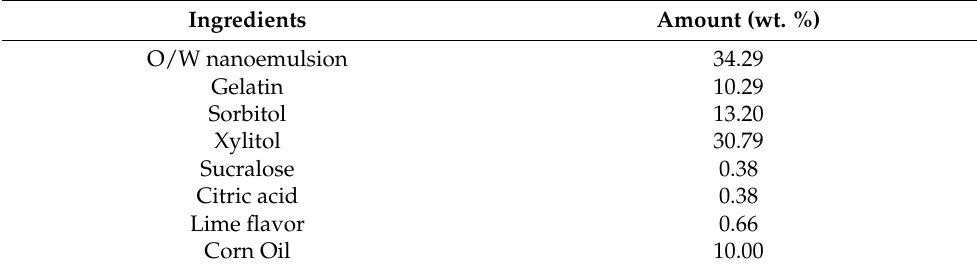
Table 2. Nano gummy formula with 10 wt. % corn